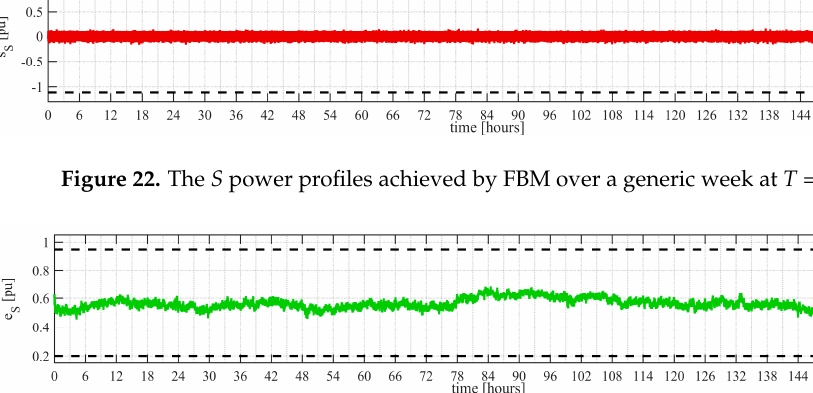
Figure 23. The S energy evolution achieved by FBM over a generic week at T = 24 h. Table 9. Objective function values ( Θ , in MW RMS ).